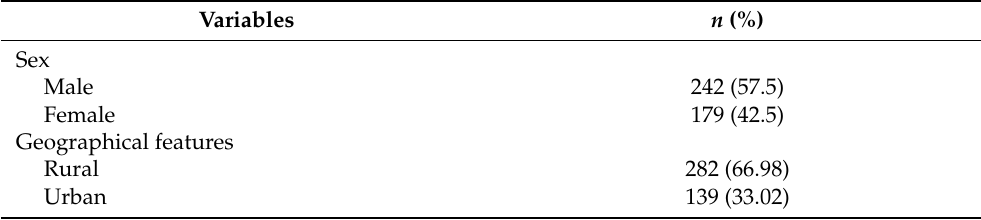
Table 1. The demographics of hospitalized children with febrile neutropenia ( n = 421).